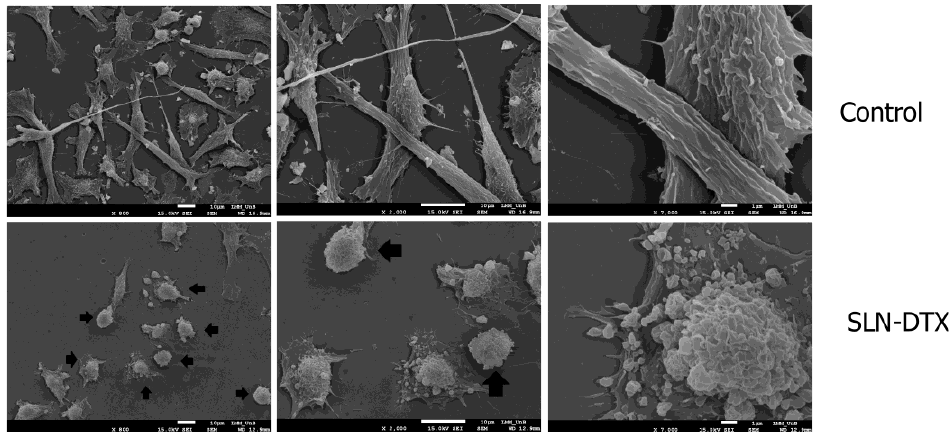
Figure 4. Scanning electron microscopy of MDA-MB-231 cells after 72 h of treatment with SLN-DTX. Arrows indicate cells that have lost their extensions. Changes in cell surface after treatment are visible, as is the reduction in cell density.